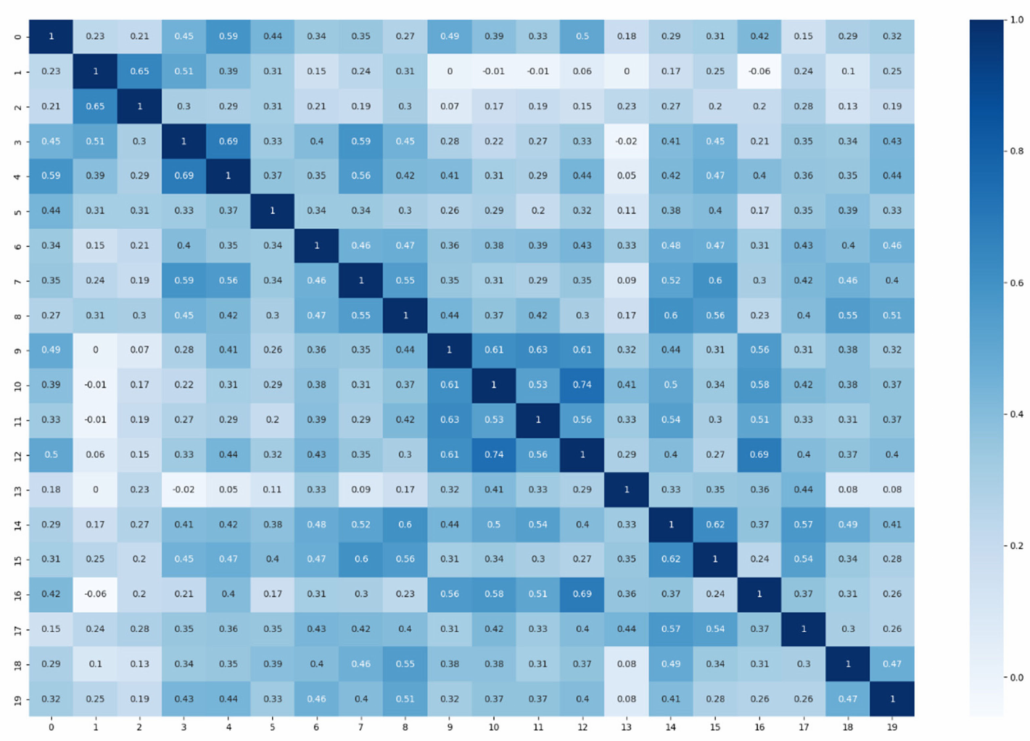
Figure 4. Heatmap matrix of the scores assigned to each sentence after measuring the similarity. Only 20 sentences were